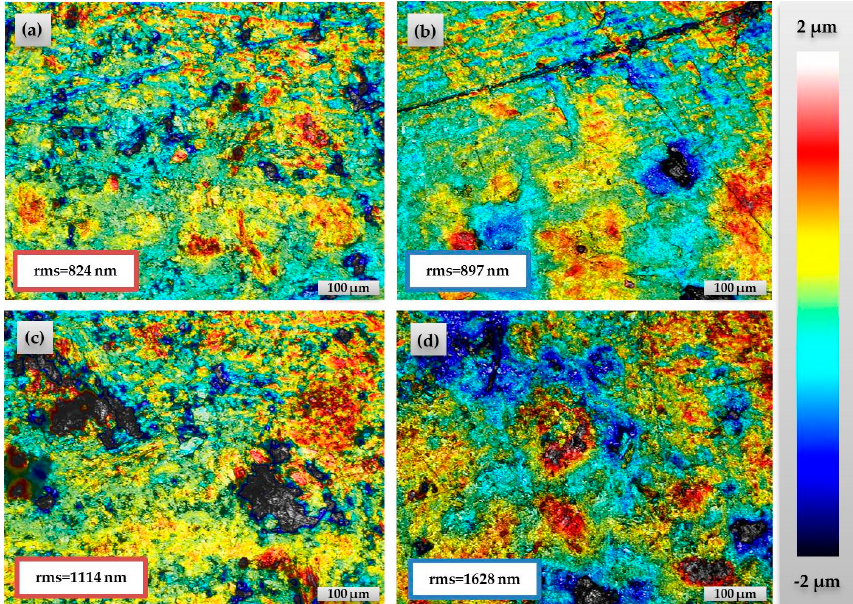
Figure 4. Confocal microscopy images of pre-activated BPPs in ( a ) set-up A and ( b ) set-up B, and BPPs after electrochemical aging in ( c ) set-up A and ( d ) set-up B. rms, root mean square surface roughness.